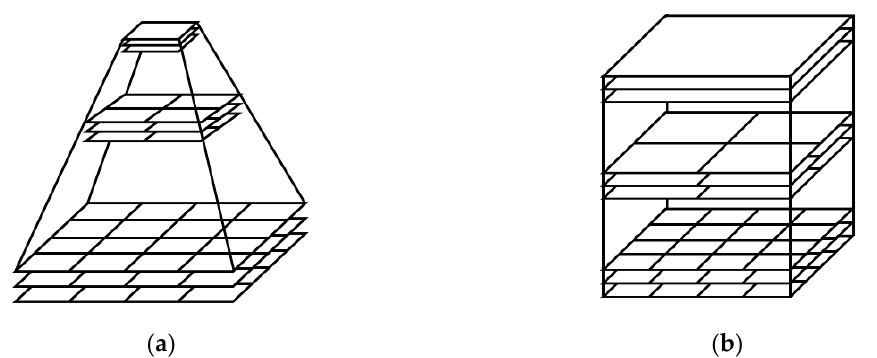
Figure 5. Multi-scale image feature structure: ( a ) pyramid structure of the images; ( b ) cuboid structure of the images. The framework of the algorithm is shown in Figure 6.